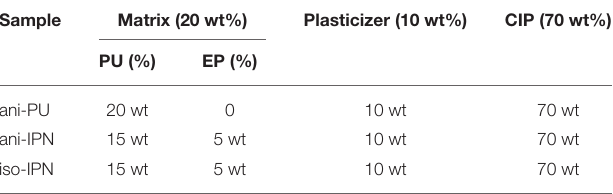
TABLE 1 | Detailed formation of MRE samples with different proportions of EP.